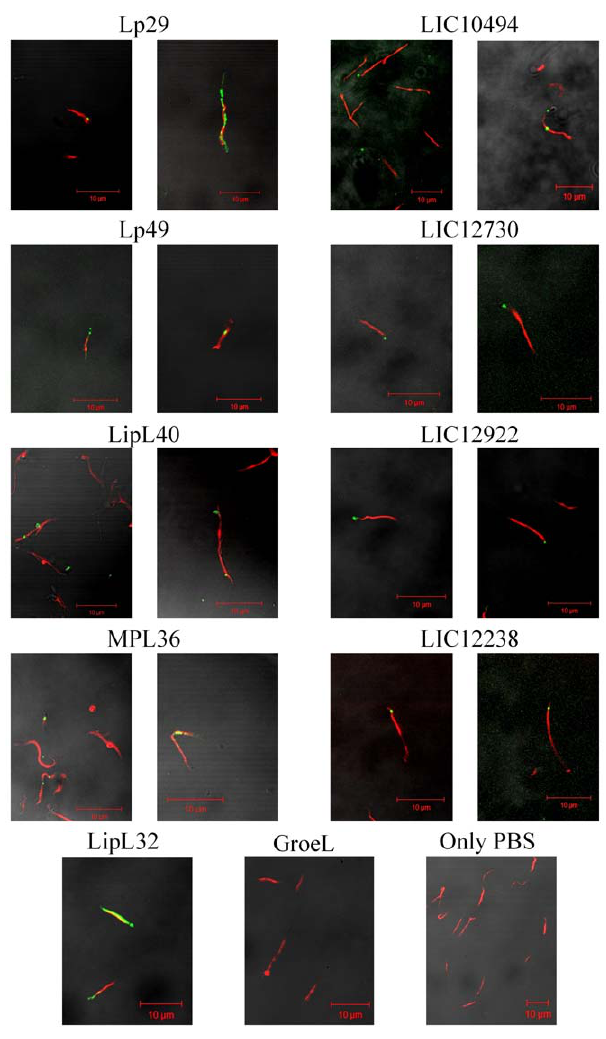
Figure 2. Cellular localization of proteins in L.interrogans by L- IFA. Protein recognition by L-IFA. Proteins in live L. interrogans serovar Copenhageni isolates were recognized by FITC-conjugated antibodies against Lp29, Lp49, LipL40, MPL36, LIC10494, LIC12730, LIC12922, LIC12238 and LipL32 (surface-exposed lipoprotein, positive control), but not against GroEL (a protoplasmic cylinder marker) and PBS (negative control) under confocal microscopy. The leptospires were identified using the DNA counterstain propidium iodide. Panels are composite images of propidium iodide- and FITC-stained slides. Magnification, 600 6